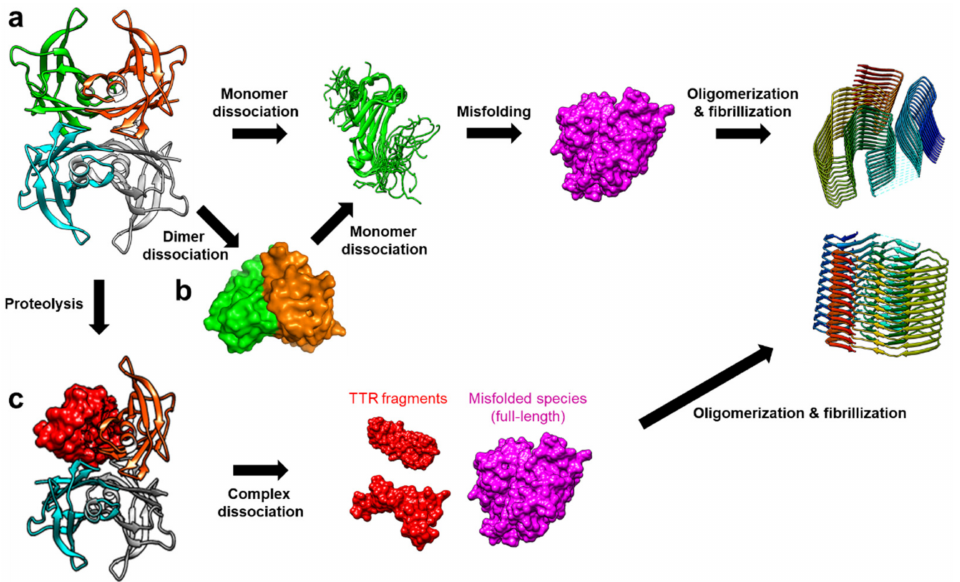
Figure 2. The amyloidosis pathways of TTR. ( a ) Tetramer dissociation into monomers is one of the dominant causes of TTR amyloidosis. The dissociated monomers are more susceptible to misfolding, resulting in aggregation into non-native oligomers and amyloid fibrils [20]. ( b ) Alternatively, it was suggested that TTR dimers are formed as an intermediate state in the tetramer dissociation mechanism [32]. ( c ) Another notable aggregation mechanism was recently proposed to involve proteolysis of TTR, which compromises the tertiary and quaternary stability of TTR, and facilitates the formation of the misfolded monomers. These TTR fragments are more amyloidogenic, thus, aggregating with full-length proteins to form amyloid fibrils even at a physiological pH